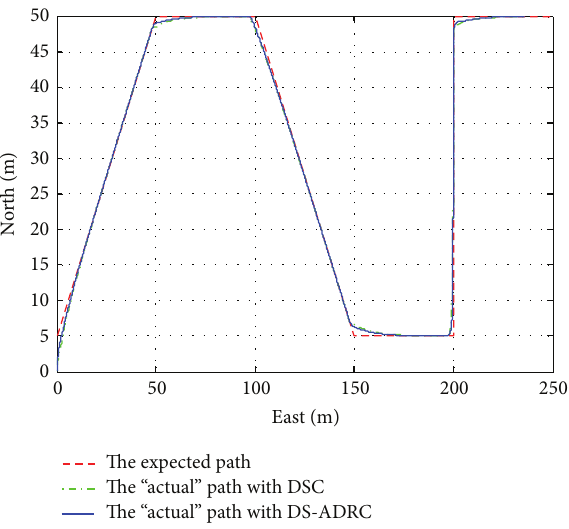
Figure 6: The output of force.